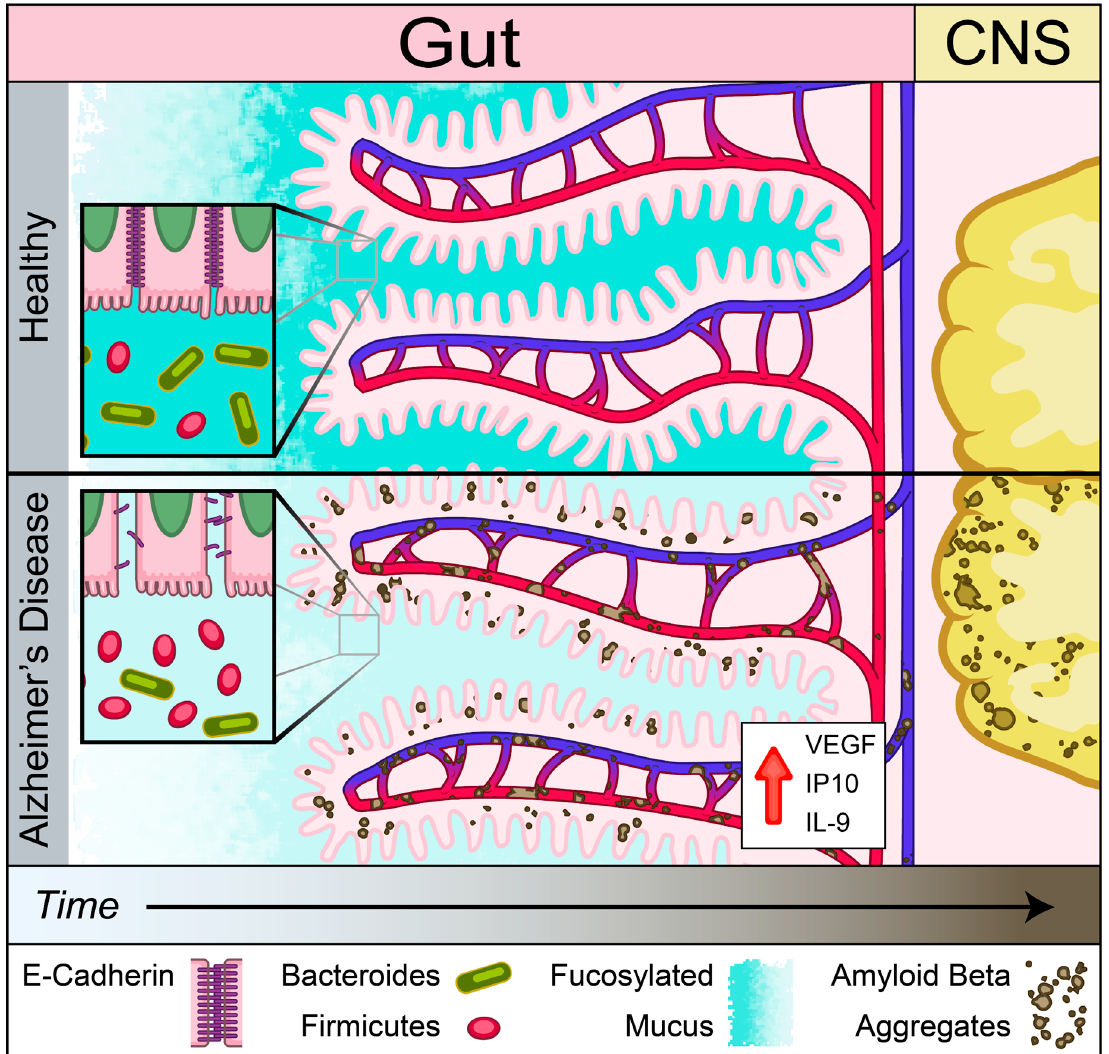
Figure 8. Schematic of gut–brain axis changes in Tg2576 mouse model of AD. Gut precedes in A β pathology compared to brain identified using Tg2576 AD mouse model. Reduced mucus fucosylation, reduced e ‐ cadherin and increased IL ‐ 9, VEGF ‐α , and IP ‐ 10 associated with A β depositions in the gut. A β depositions was co ‐ localized with blood vessels before central pathology in Tg 2576 AD mouse model.